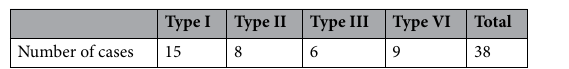
Table 6. The number of four registration situations.